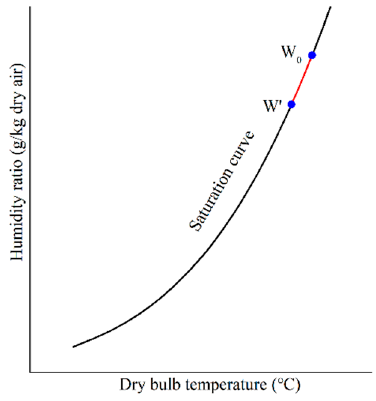
Figure 3. Schematic diagram of water conservation technology.